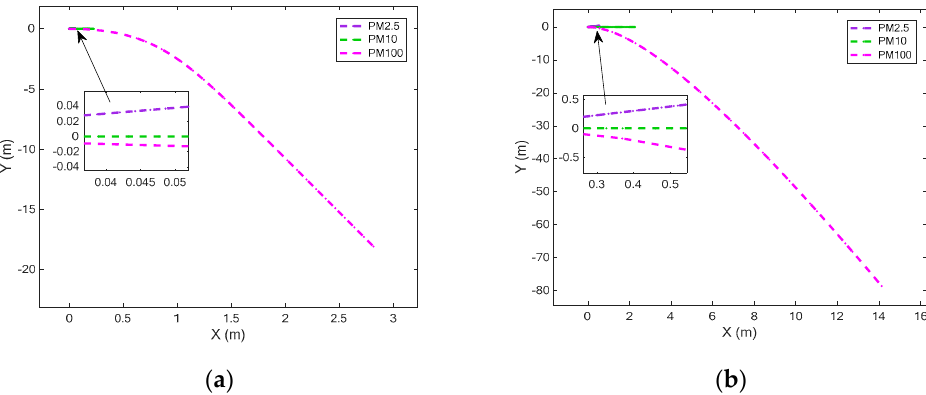
Figure 11. E ff ect diagram of atmospheric particulate separation under di ff erent drag coe ffi cient: Figure 11. Effect diagram of atmospheric particulate separation under different drag coefficient: ( a ) ( a ) mu = 10 − 6 ; ( b ) mu = 10 − 7 mu = 10 − 6 ; ( b ) mu = 10 − 7 .